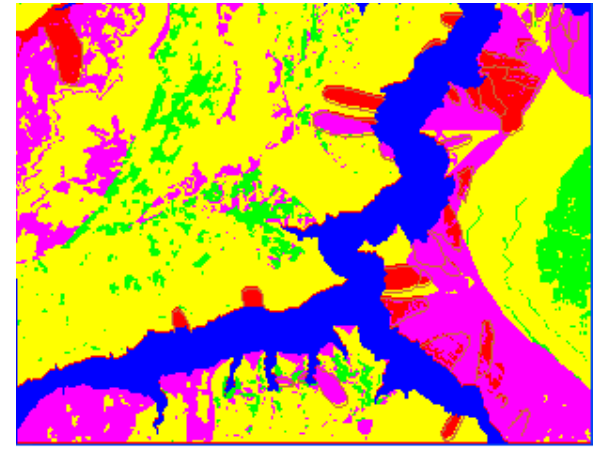
Figure 26. Forecast results of decision tree added to the disaster distribution